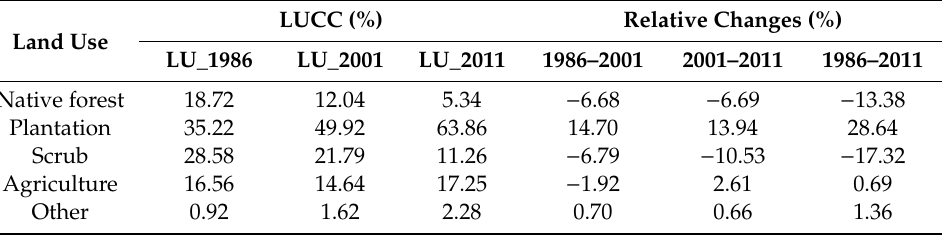
Figure 3. Spatial representation and percentage of land-use change area for LU_1986, LU_2001, and LU_2011. Table 3. Percentages of land-use area for the LU_1986, LU_2001, and LU_2011 scenarios and their relative changes.